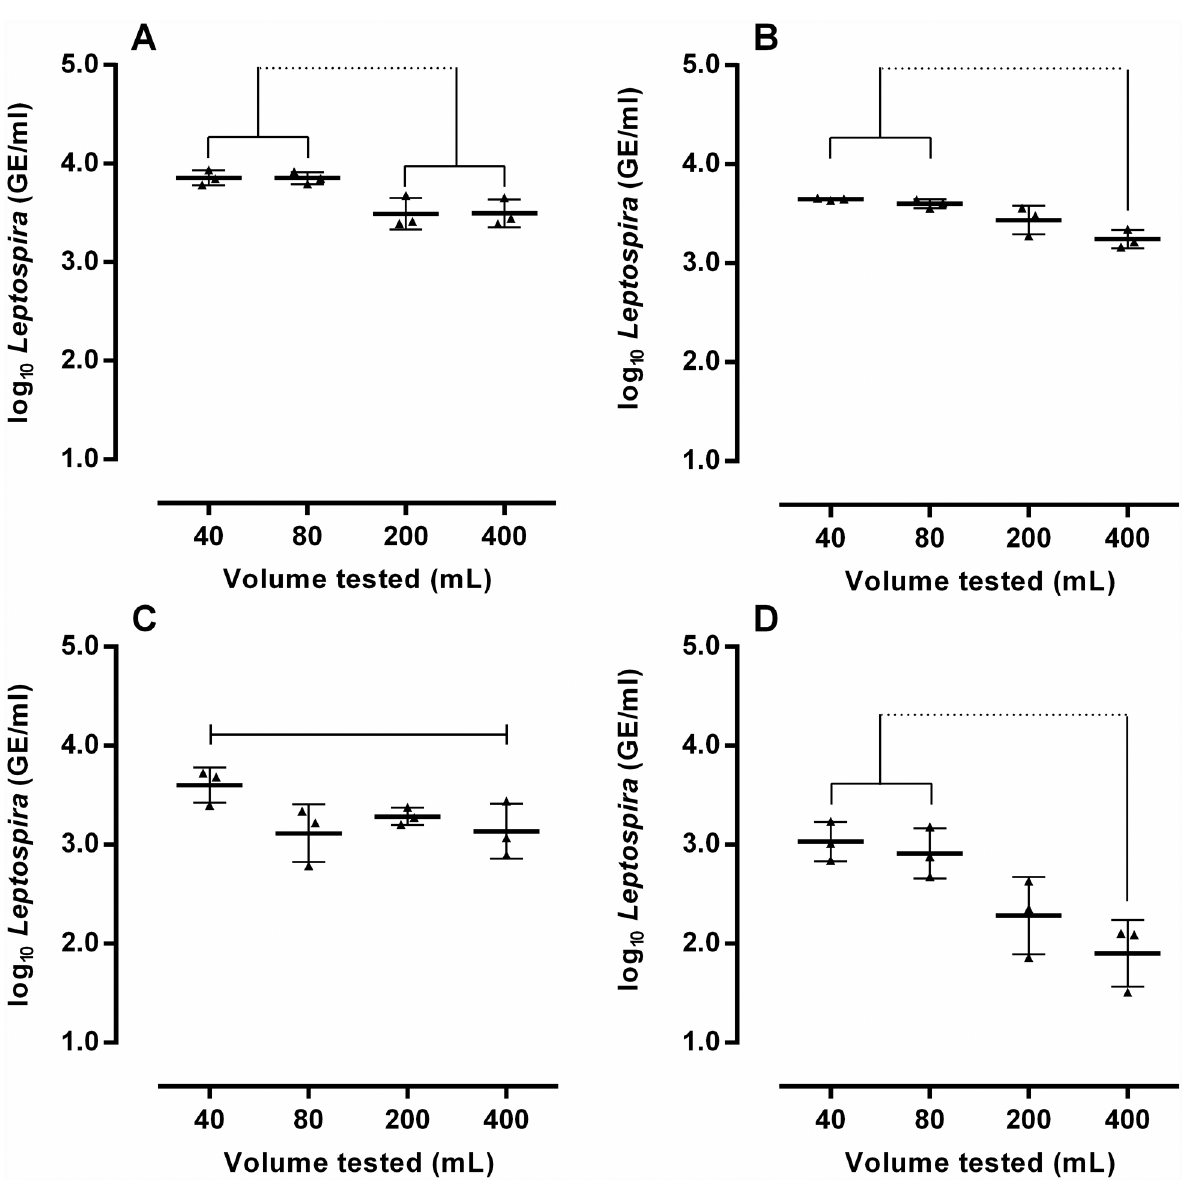
Fig 2. Determination of the optimal volume to be tested by qPCR for different water types: ultrapure water (A), river (B); pond (C) and sewage (D). Different volumes of each water type were spiked with 1 × 10 5 leptospires/mL to assess Leptospira recovery. Error bars represent the geometric mean ± SD of the concentrations as determined by qPCR in three independent experiments. Continuous lines connect groups whose average leptospiral DNA concentrations are not statistically significant (p > 0.05). Groups whose averages are significantly different (p < 0.05) are connected by a dashed